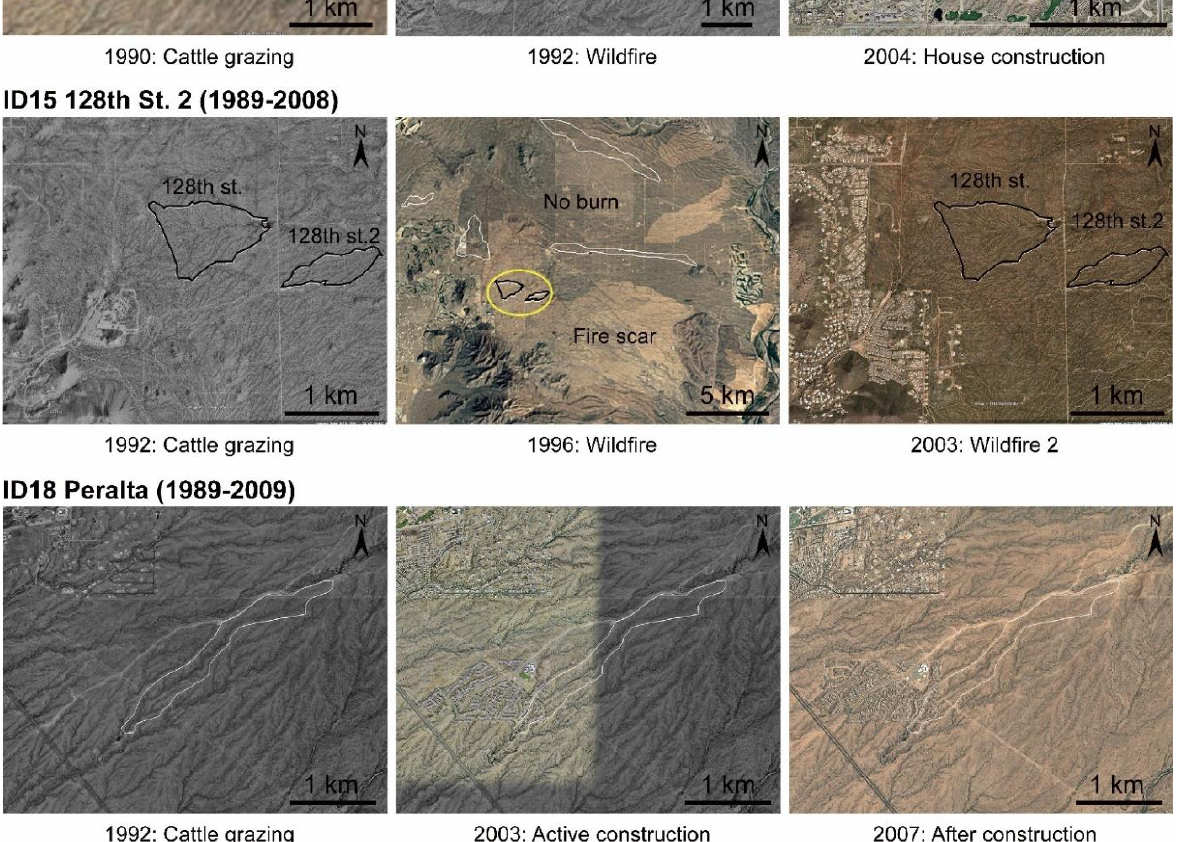
Figure 6. Historic aerial photography showing the typical land-use changes in four stock pond watersheds. The ID numbers correspond with the numbers in the figures and tables of this paper.